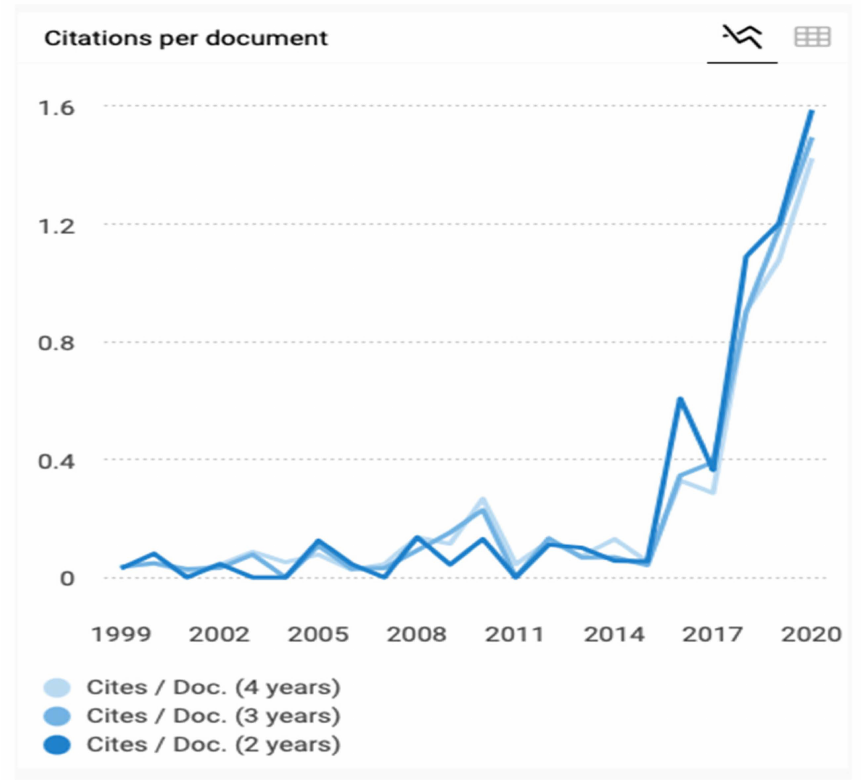
Figure 7. The journal citations vs. number of papers for two, three, and four yearly periods. Two yearly values corresponding with Clarivate Impact Factor (IF) measure. More about IF can be found in, e.g., [3].